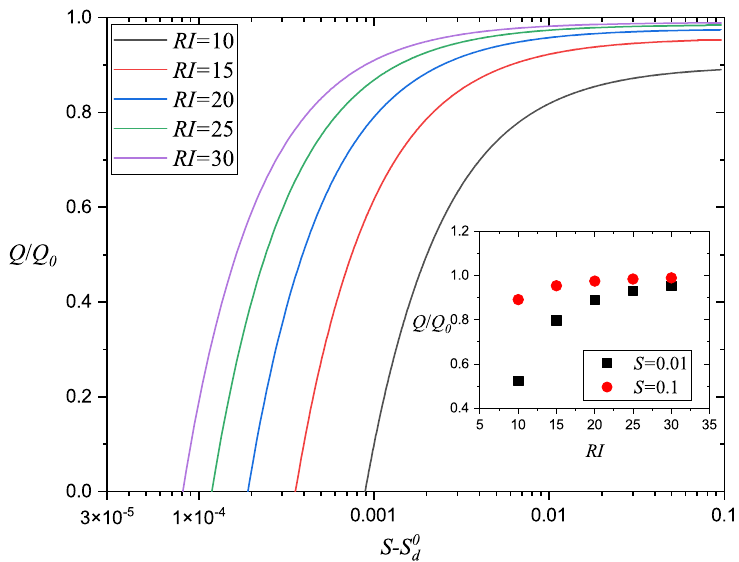
Figure 10. The relationship between Q / Q 0 and the wind strength, where Q / Q 0 is the ratio between the sand flux on ripple surface to the one on the flat surface. Different line colors represent differ- ent ripple indexes. The inset shows how Q / Q 0 varies with RI . All the results are derived from Equation